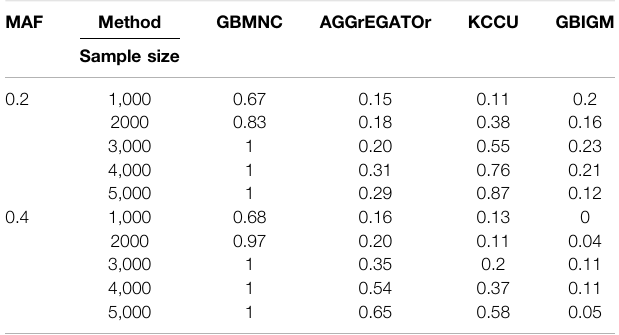
TABLE 5 | The statistical power of simulation studies for GBMNC, AGGrEGATOr, KCCU, and GBIGM under models with h (cid:1) 0 . 025, MAF ∈ { 0 . 2 , 0 . 4 } , and sample sizes that varied from 1 k to 5 k